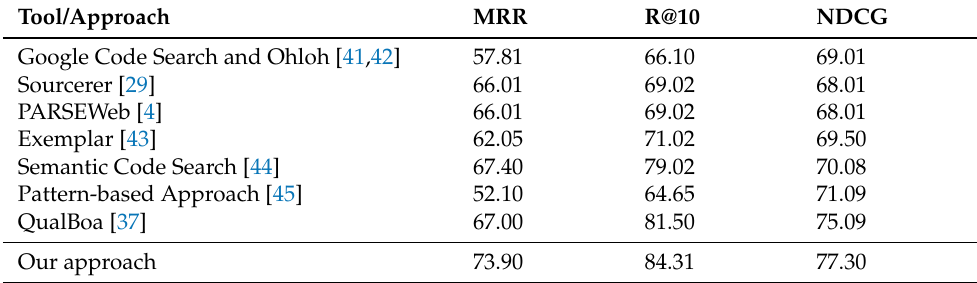
Table 5. Comparison